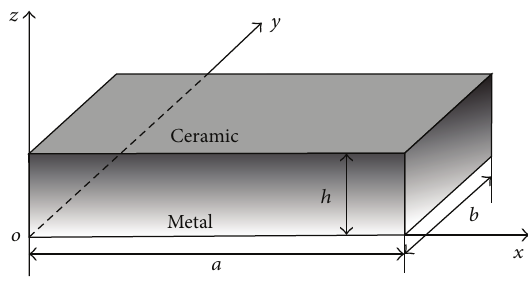
Figure 1: Geometry and coordinates of the FGM